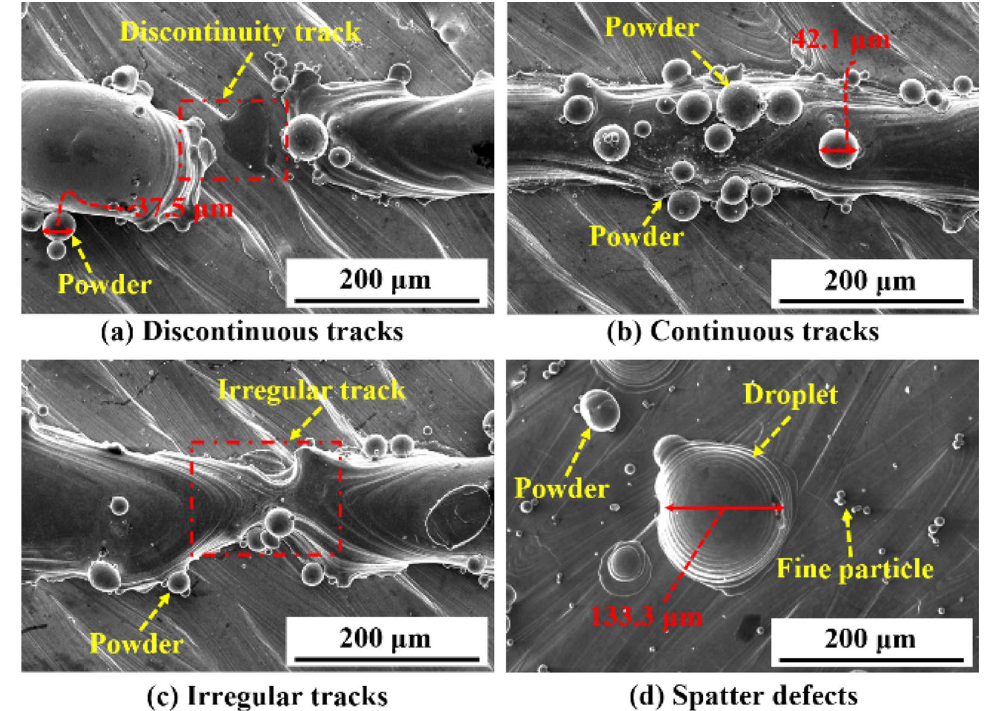
Figure 2 Typical morphologies of LPBF